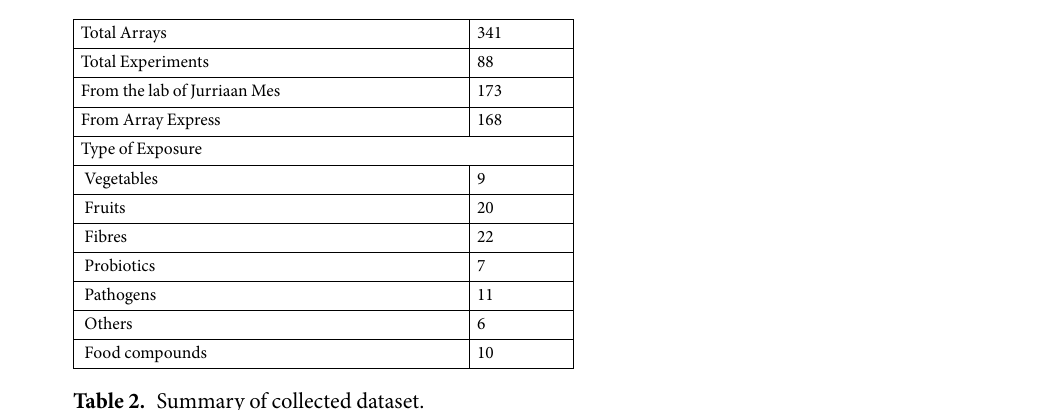
Table 2. Summary of collected